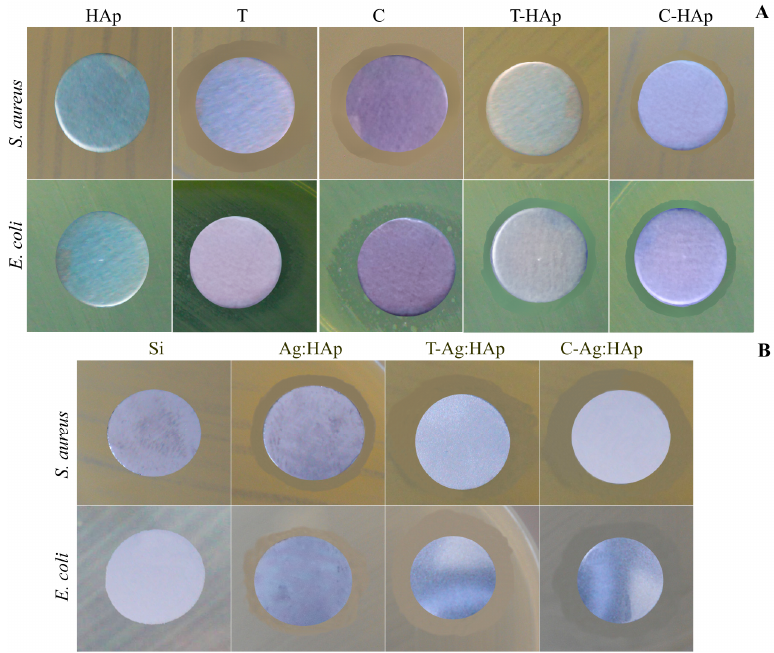
Figure 11. Antibacterial activity against S. aureus 0364 and E. coli ATCC 25922 cultures of: ( A ) HAp, T-HAp and C-HAp, Ciprofloxacin, Tetracycline thin films and ( B ) Ag:HAp, T-Ag:HAp, C-Ag:HAp thin films.